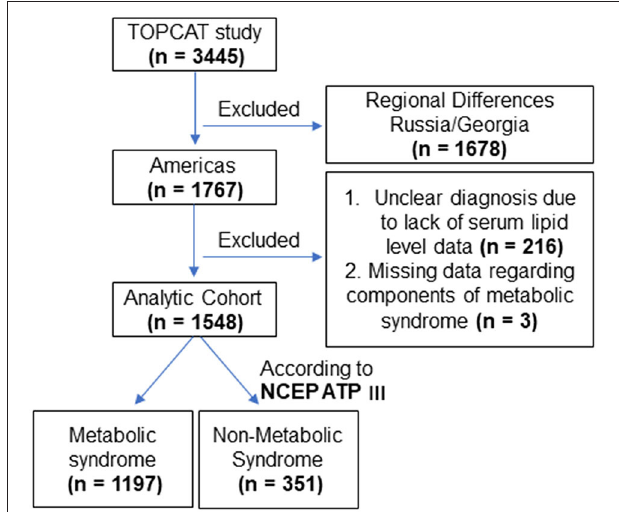
FIGURE 1 | The enrollment chart, which shows the patients that were included in the final sample; TOPCAT: Treatment of Preserved Cardiac Function Heart Failure with an Aldosterone Antagonist trial; NCEP ATP III: metabolic syndrome diagnosis based on the working definition proposed by the National Cholesterol Education Program (NCEP) Adult Treatment Panel (ATP) III.